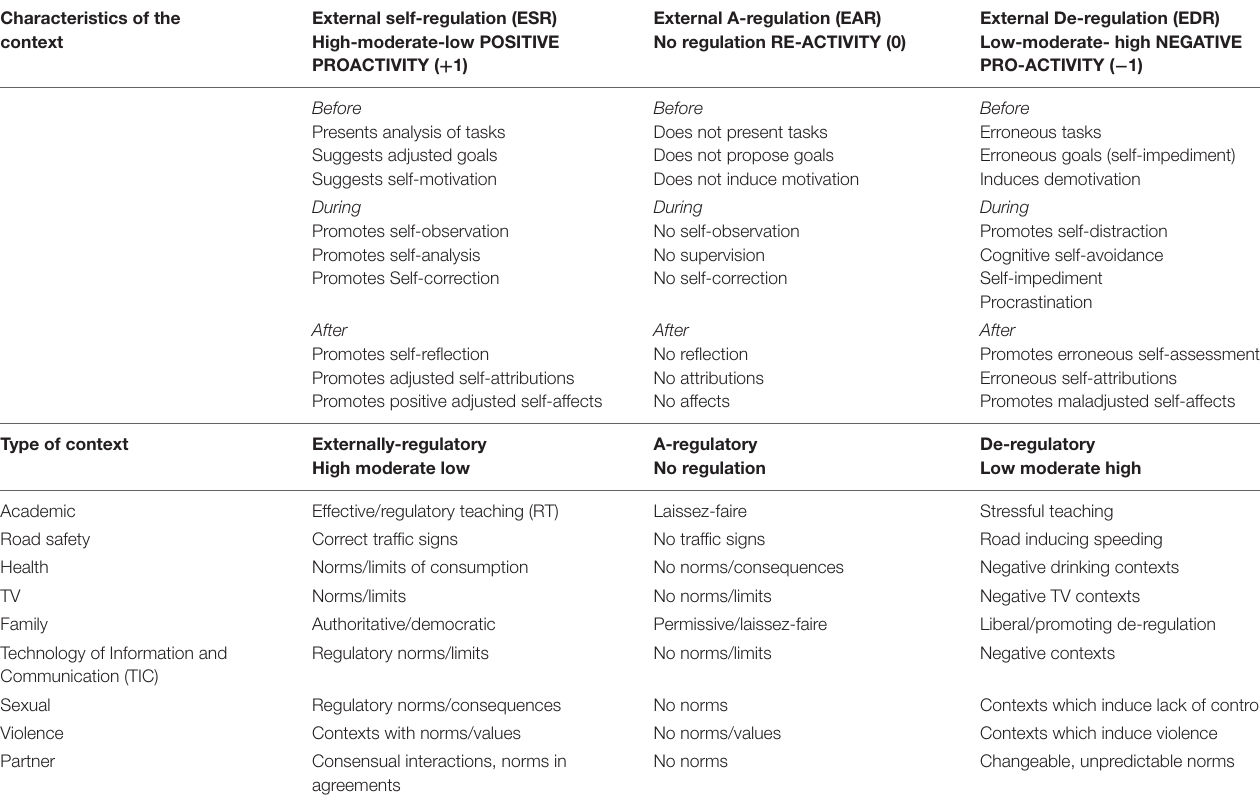
TABLE 2 | Conceptual continuum of the Externally-Regulatory Learning (ERL) context dimension. Characteristics of the